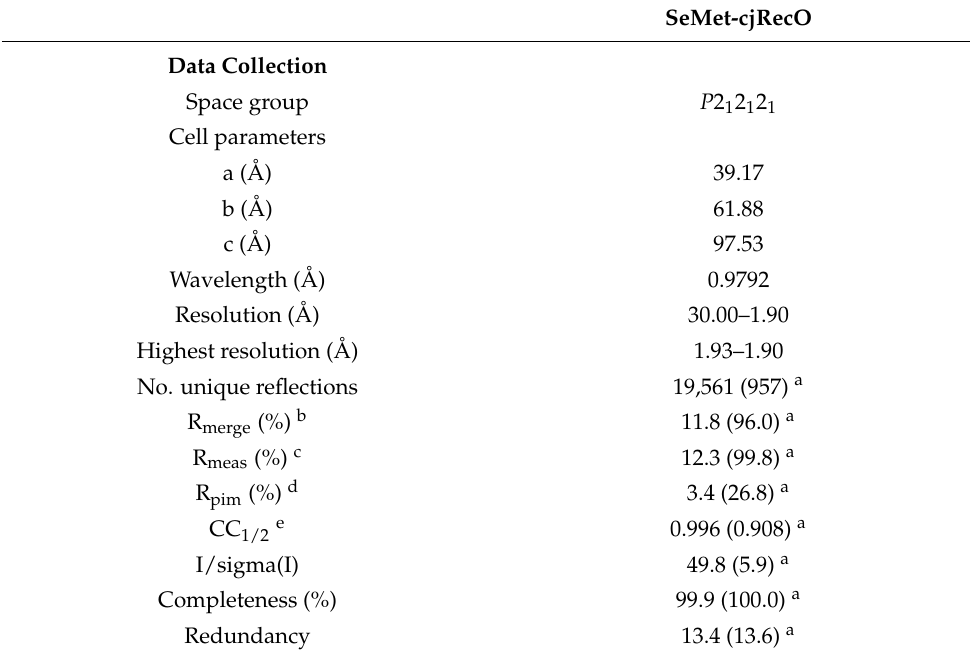
Table 1. Crystallographic statistics for SAD phasing of the SeMet-cjRecO structure.